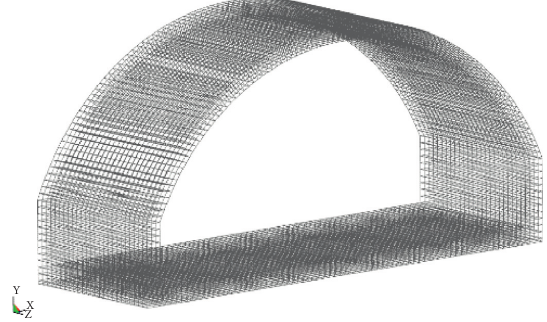
Figure 2: The schematic diagram for layout.